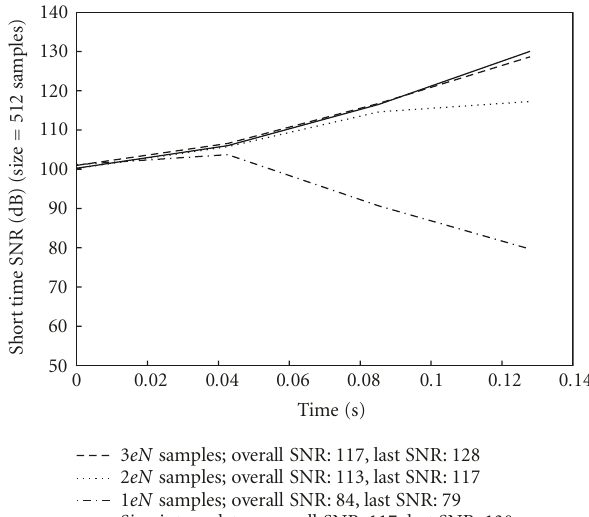
Figure 7: SNR over time for three di ff erent oversampling factors and a sinc interpolator. Test signal: sparrow chirp, 16bits, 16000 Hz, 2048 samples.